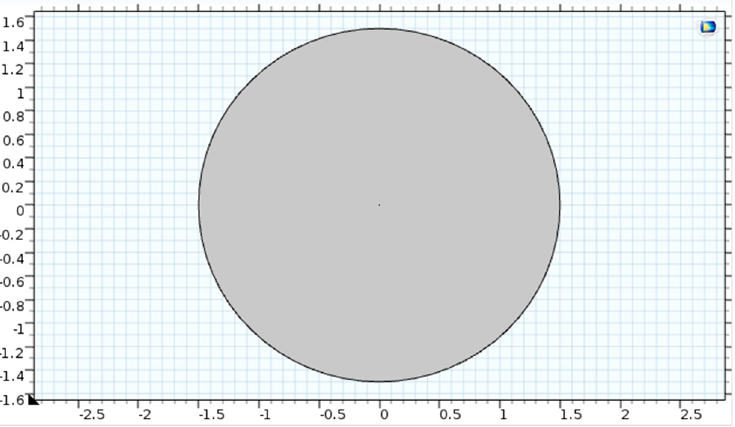
Figure 1. A schematic view of the system geometry.